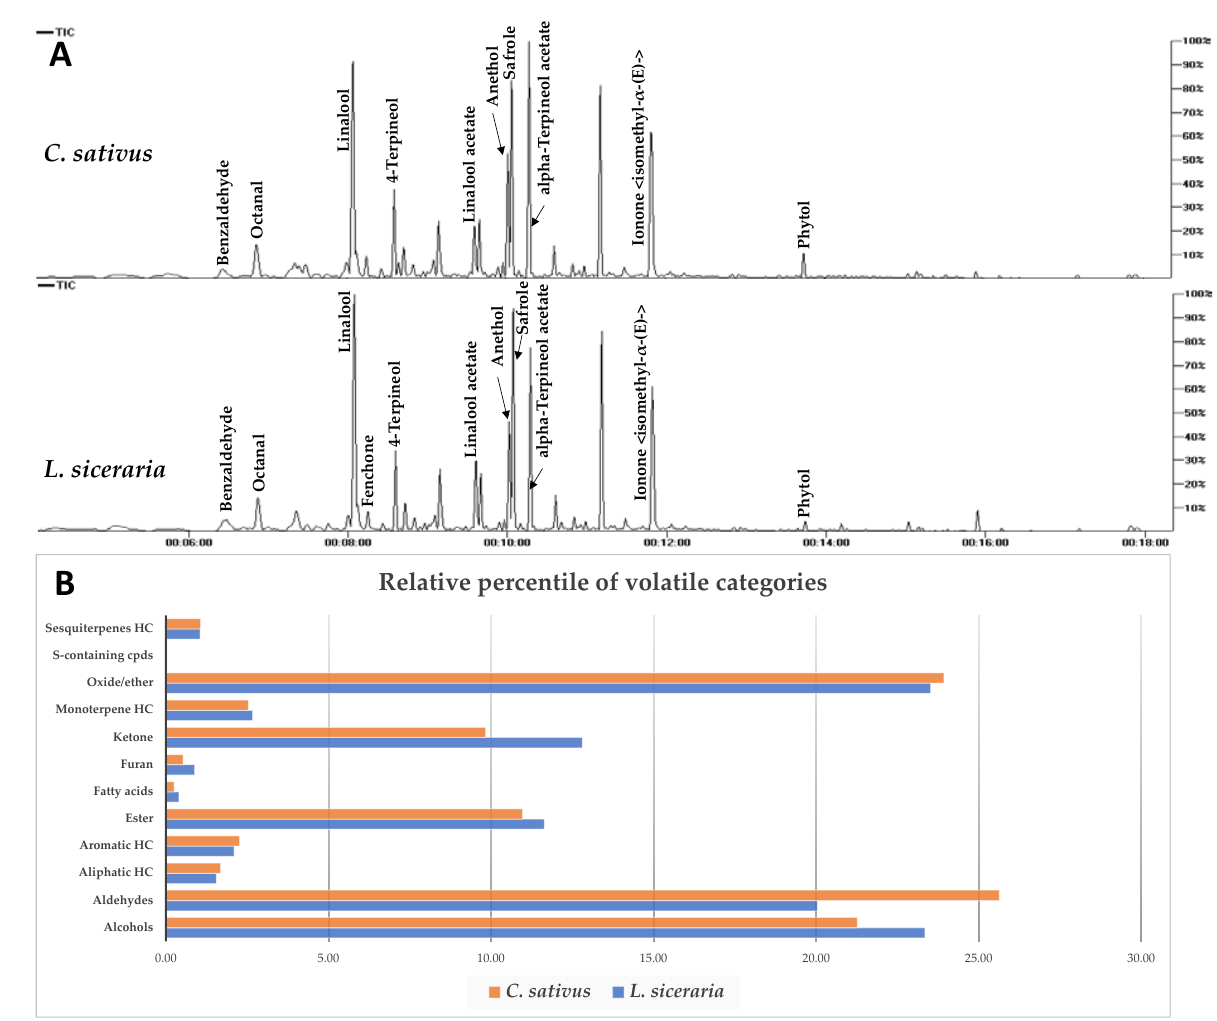
Figure 3. ( A ) Total ion chromatogram of C. sativus and L. siceraria aroma constituents as analyzed via SPME GC/MS. Assigned compounds names follow those shown in Supplementary Table S1. ( B ) Relative percentile of different volatile categories detected via SPME-GC/MS analysis in C. sativus and L. siceraria fruits.